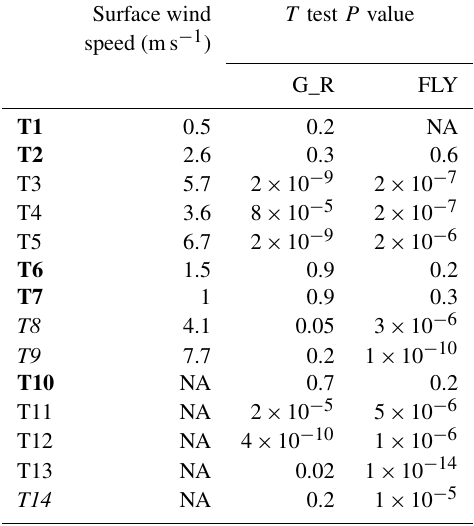
Table 2. Summary of the dates, time, wind speed, and t test results ( p value) of each test flight. Wind speed values (at 1.5m) are the wind speed in the hour closest to the experiment time. From T10 to T14 the wind speed data are not available (NA) because the instru- ment recording the data had broken. Flights highlighted in bold font indicate that the results are not significantly different at 5% signif- icance. Flights marked in italic font indicate that the PNC on the ground with the rotor on are not significantly different from G_NR, and flights marked in standard font indicate that there are significant differences in both G_R and FLY when compared to G_NR.